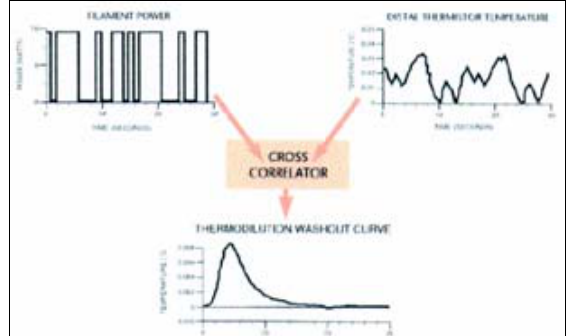
Fig. 3 (cid:150) Diagrama mostrando a corela(cid:231)ªo entre os impulsos elØtricos produzidos no filamento do cateter de Swan Gans, as mudan- (cid:231)as de temperatura captadas no thermistor distal e a curva de terma dilui(cid:231)ªo gerada